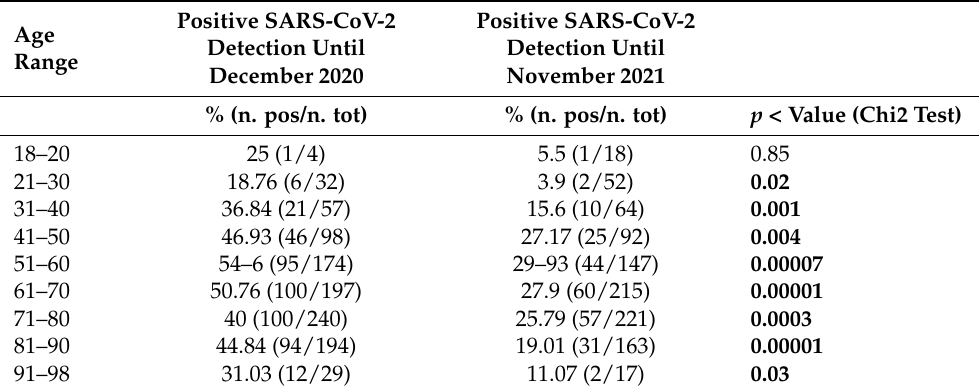
Table 4. Stratified population-based age distribution between 2020 ( n = 475) and 2021 (232), consid- ering SARS-CoV-2 positive rate.